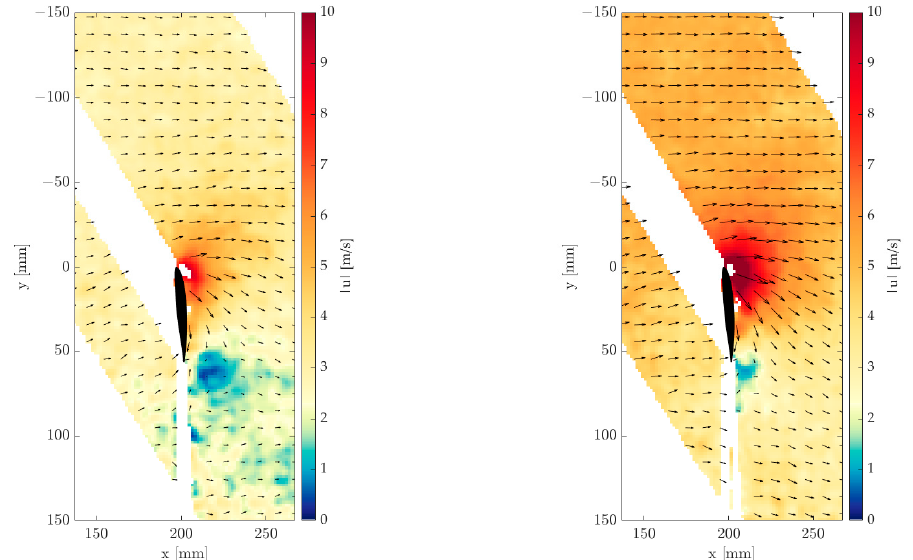
Figure 9. Processed flow field in sinusoidal inflow. Minimum of sinusoidal inflow ( left ) and maxi- mum of sinusoidal inflow velocity ( right ).